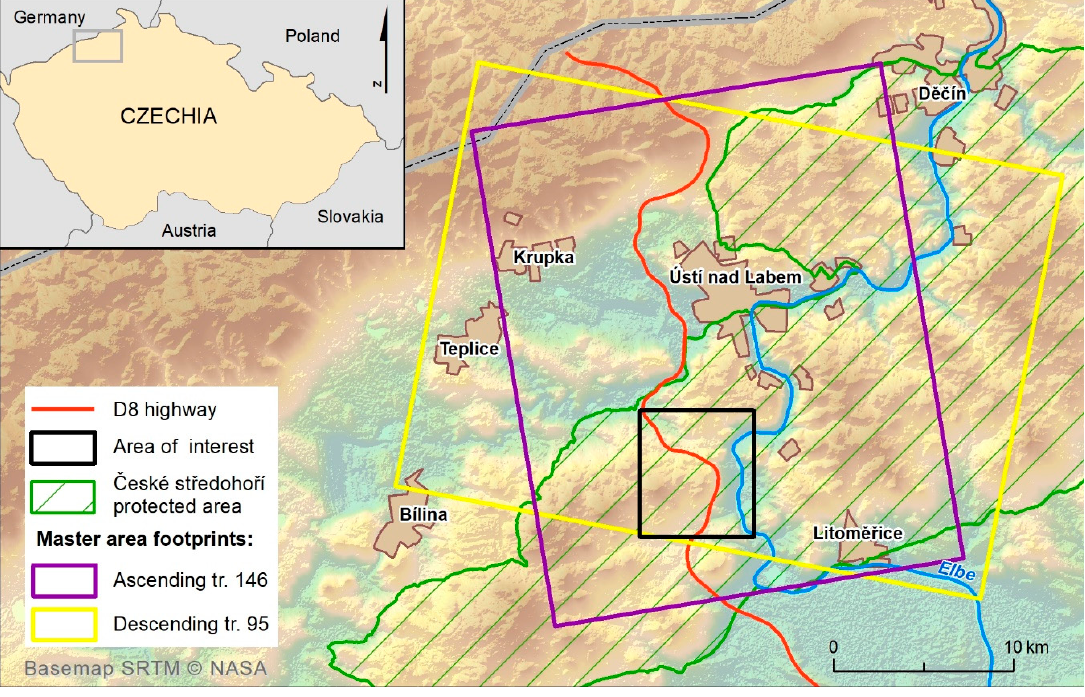
Figure 1. Area of interest with delineated Master areas footprints of ascending and descending pass.